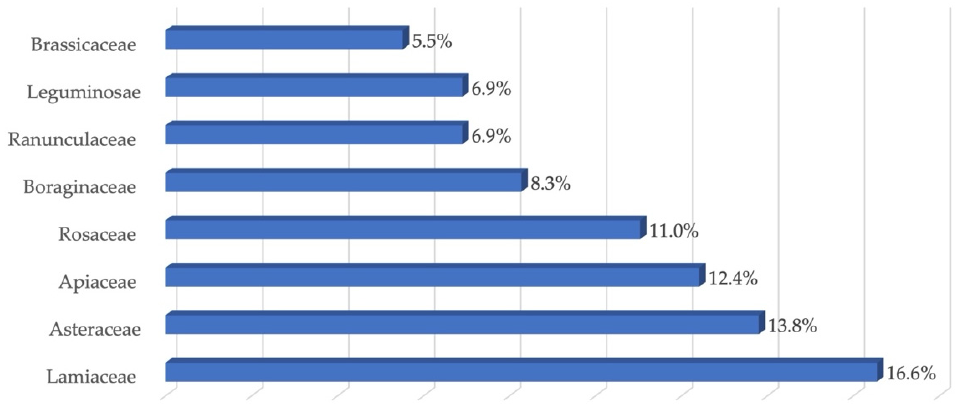
Figure 1. Percentage of abundance of taxa per family.